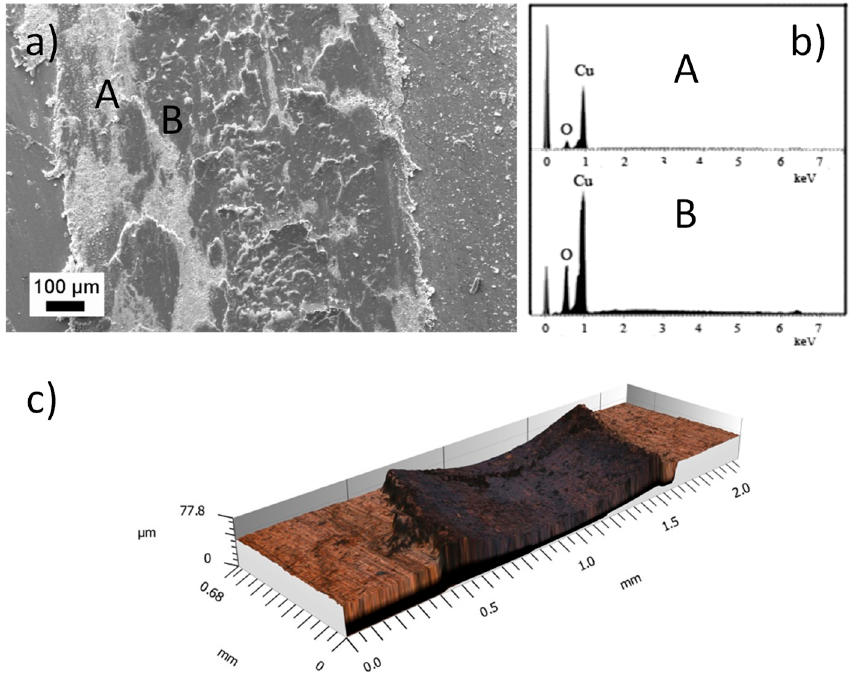
Figure 2. ( a ) SEM images of the wear track of the pure copper sample, where Energy Dispersive X-ray Spectroscopy (EDS) spectra performed in regions A and B are shown ( b ). 3D optical profiler micrograph of the worn track, where axis units are in microns ( c ).